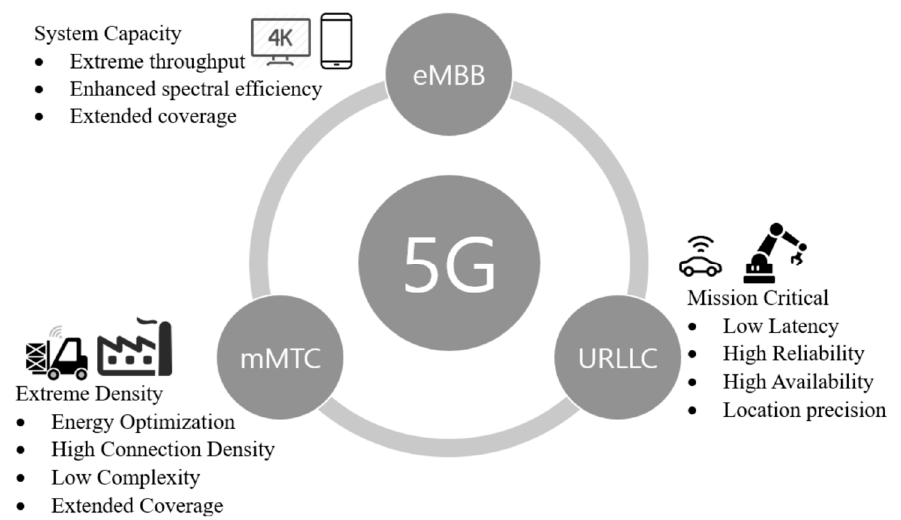
Figure 3. Features and improvement plan for future 5G [4].